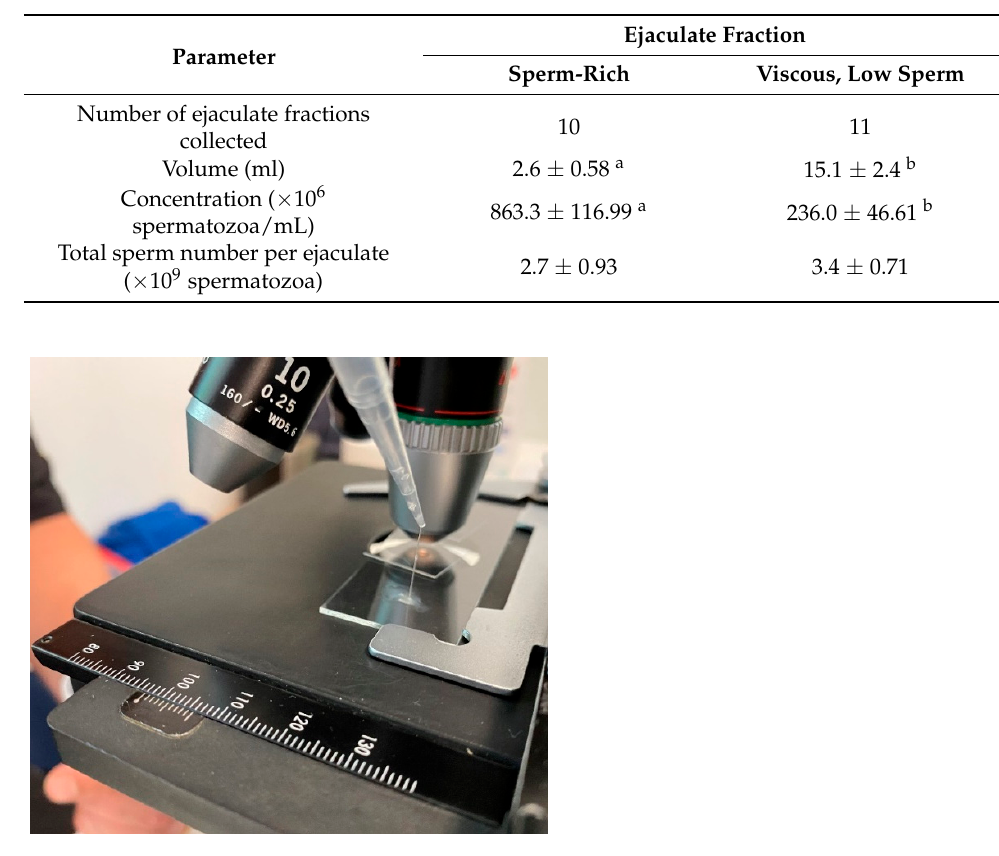
Figure 1. Visual example of viscosity witnessed in non-sperm-rich fraction of rhino ejaculate collected via electro-ejaculation.